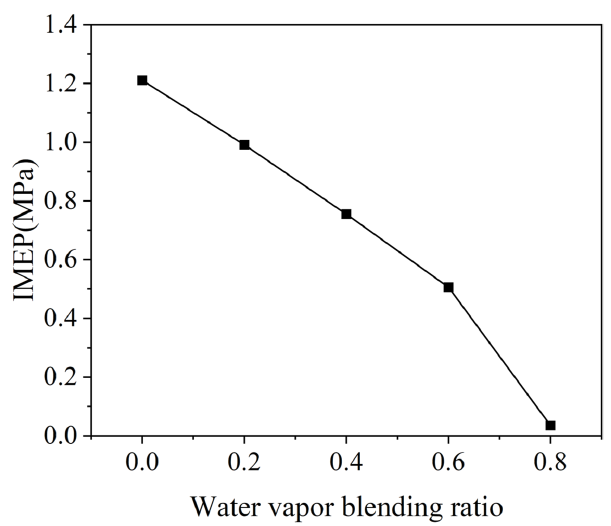
Figure 12. IMEP of the micro ‐ free ‐ piston engine under different α .